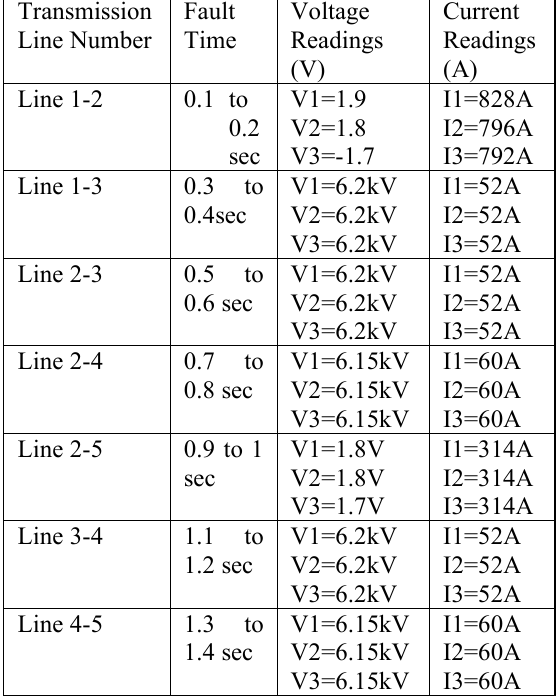
Table 2 Reading recorded by PMU during faults from